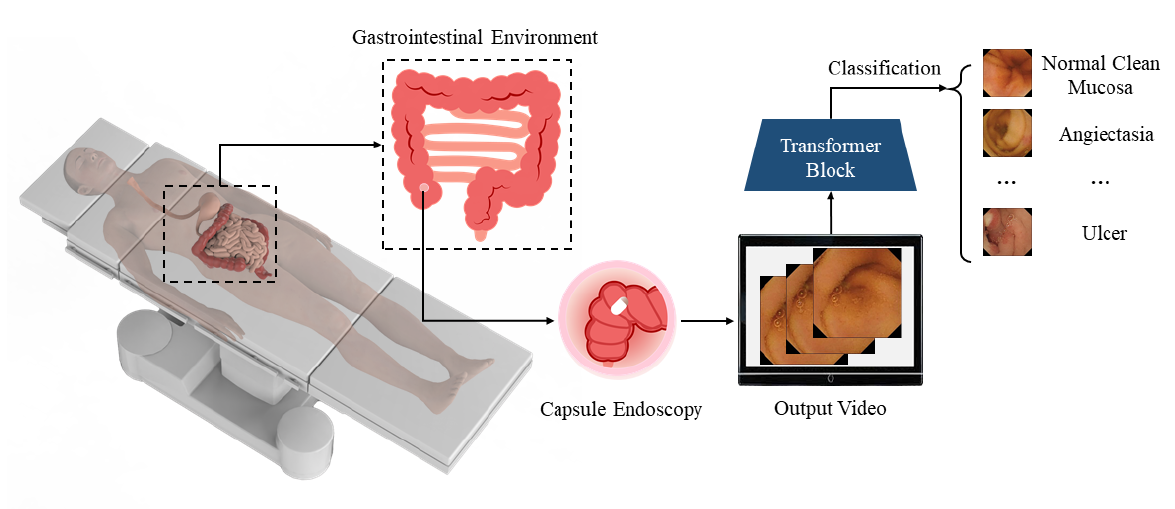
Figure 1. Overview of the capsule endoscopy system. The capsule endoscope collects images in the GI environment and outputs them in real time, and then AI algorithms process and classify the